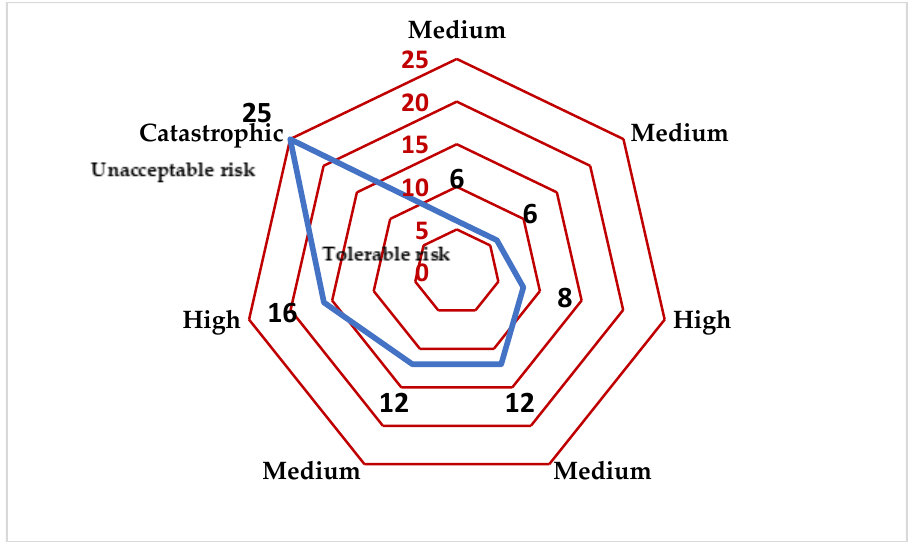
Figure 3. Graphical representation of the risk levels in supply chains. Source: (own